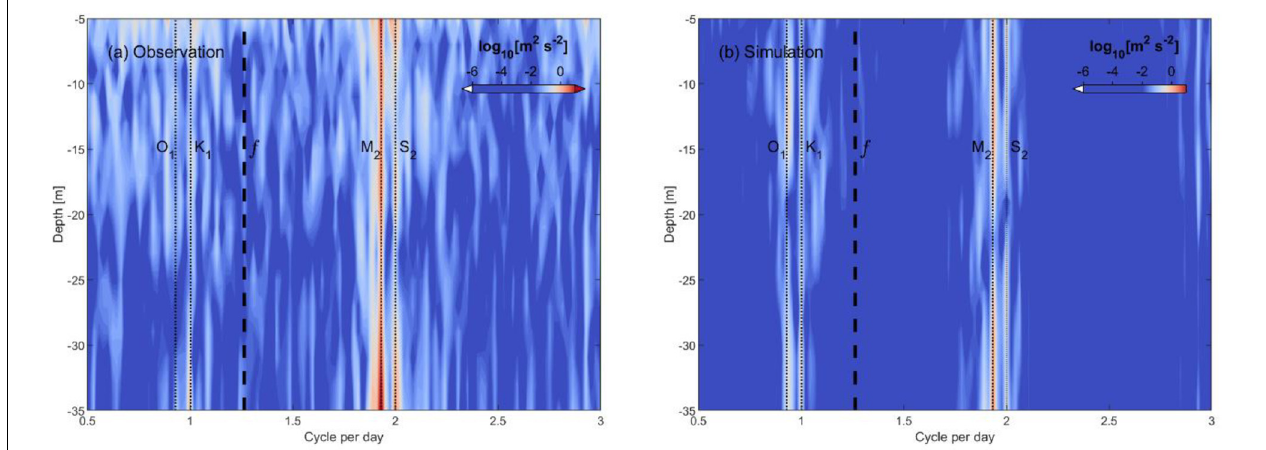
FIGURE 6 | Spectral analysis results of (a) observed and (b) simulated baroclinic current at the mooring site. The diurnal constituents K 1 , O 1 , and semi-diurnal constituents M 2 , S 2 are represented with vertical dotted lines, and the inertial frequency ( f ) is represented with the thick dotted line.